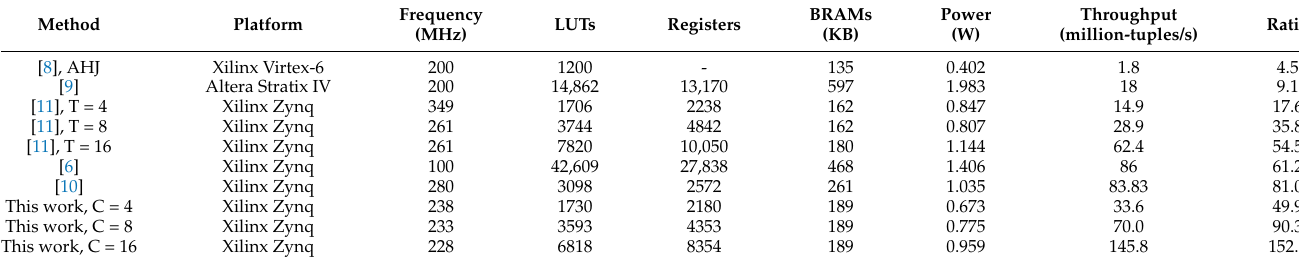
Table 1. Comparison with previous works. Each work’s power consumption is estimated using Xilinx Power Estimator. The ratio is